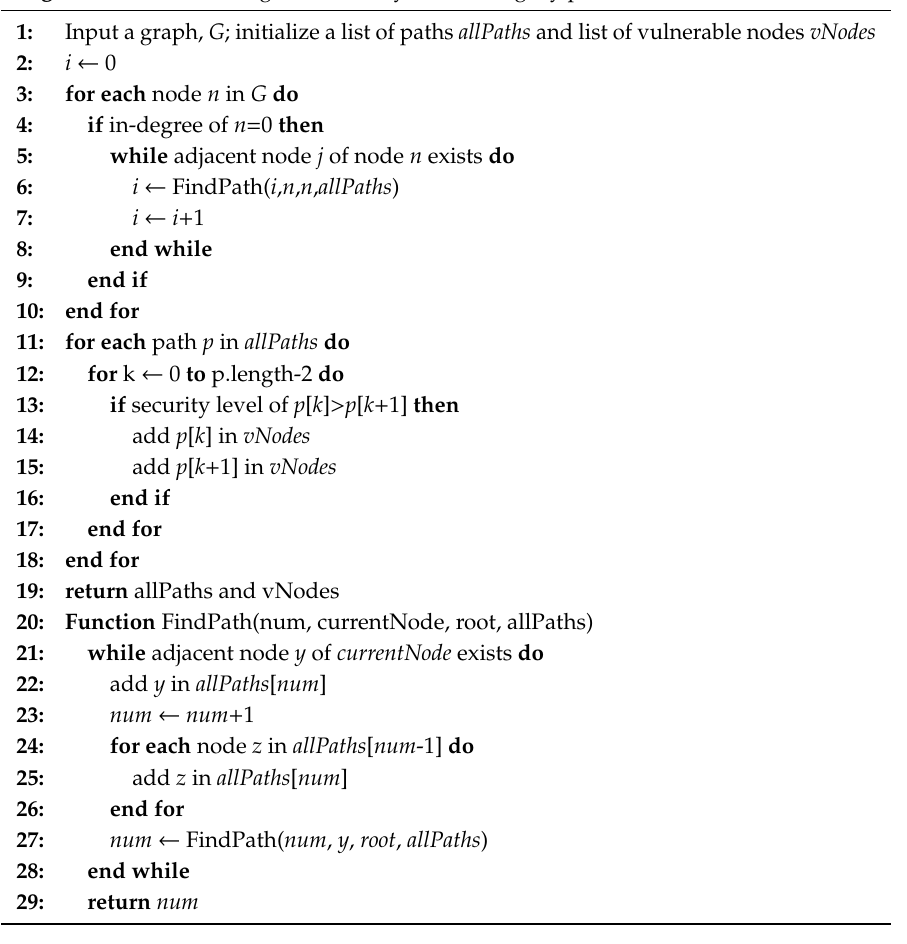
Algorithm 2 Determining vulnerability under integrity